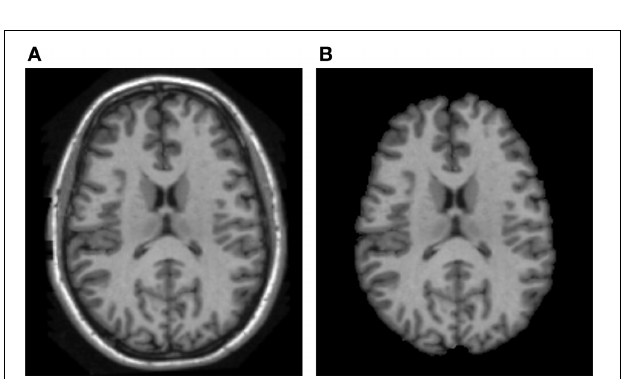
FIGURE 2 | ABC based brain skull-stripping result. (A) the brain tissue in original MRI scan, (B) the skull-stripped brain.